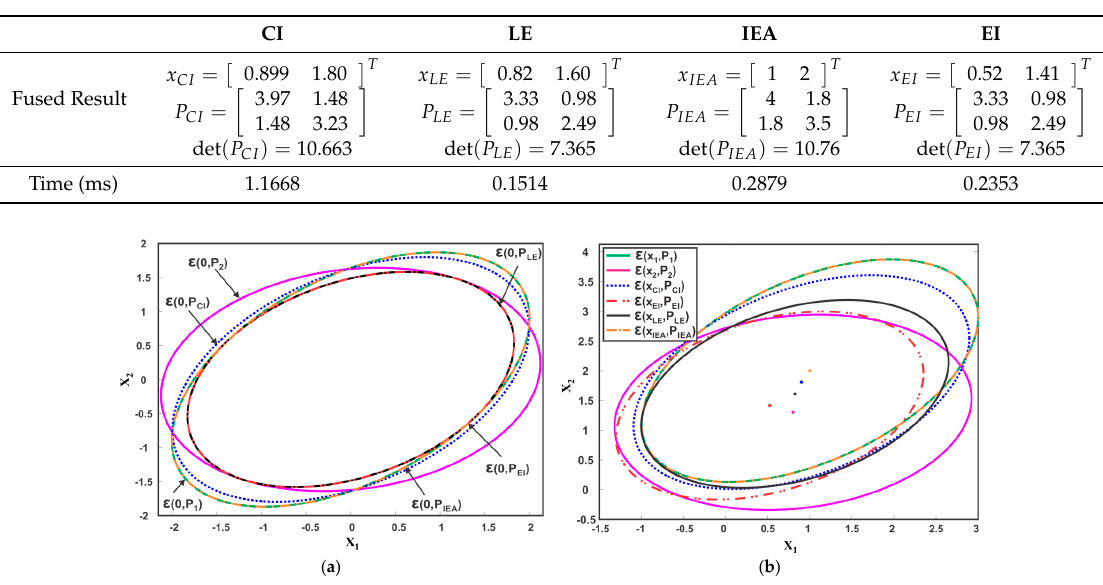
Figure 10. Two estimates ε ( x 1 , P 1 ) and ε ( x 2 , P 2 ) and their fused result provided by CI and ME methods, where three instances of ME are considered ( a ) Zero Mean ( b ) Non-Zero